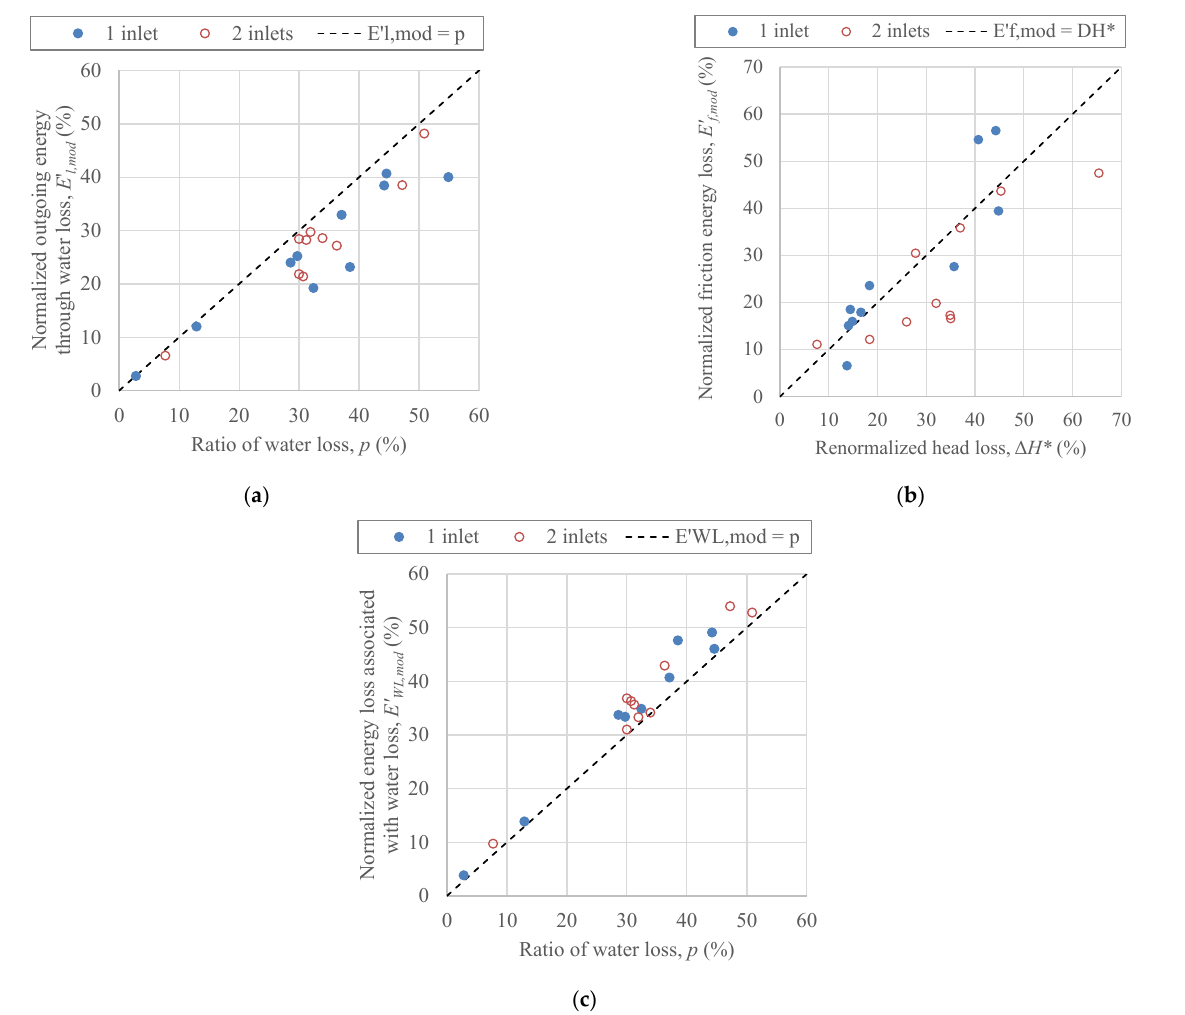
Figure 6. Relationships between energy balance components calculated by EPANET models and basic network parameters, where ( a ) E (cid:48) vs. p , ( b ) E (cid:48) vs. ∆ H (cid:48) and ( c ) E (cid:48) vs. p . l , mod f , mod WL , mod